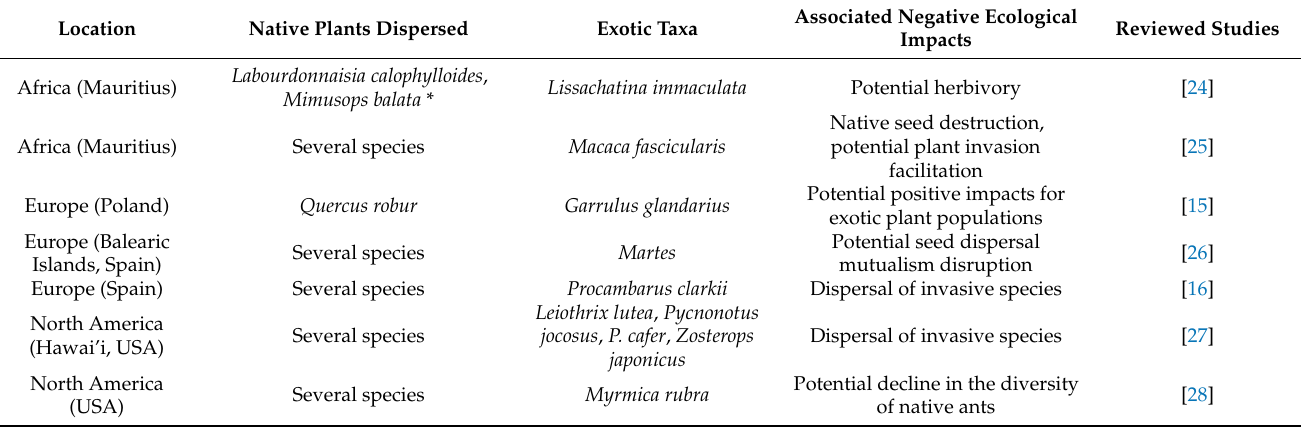
Table 1. Summary of the exotic taxa involved in native seeds dispersal and their additional ecological